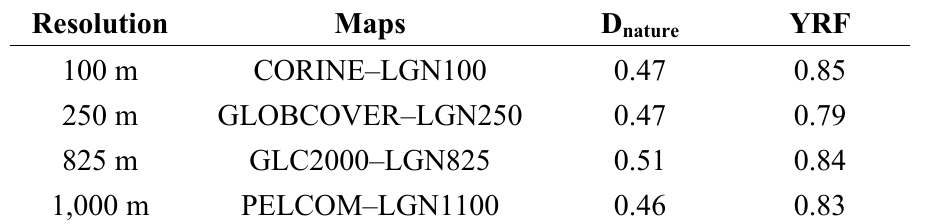
Table 5. Fuzzy numerical similarity statistics for comparison between real maps with aggregated LGN at each